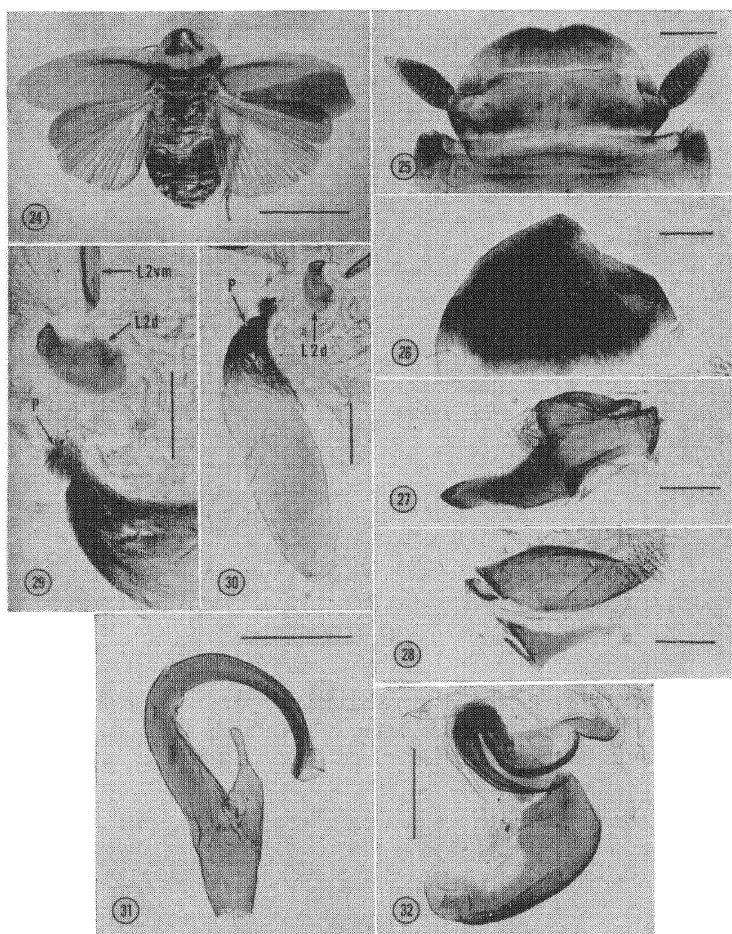
Figs. 24-32. Adult 6 of Pinaconota inaequalis (Walker) (holotype of Panchlora inaequalis Walker). 24. Adult. All structures shown in the following figs. are from this 6. 25. Supra-anal plate and eerei (dorsal). -- 26. Subgenital plate (ventral). 27. Right paraproet. 28. Left paraproet. 29- 32. Parts of the genitalia; fig. 30 shows the entire preputial modification, which is only partly shown in fig. 29. (L2vm ventromedial selerite (only apex is shown); L2d dorsal sclerite of second left phallomere; P preputial membrane). 31. R2 (second selerite of right phallomere). 32. L1 (first selerite of left phallomere). (scale" fig. 24- 10 mm; figs. 25-26 mm; figs. 27, 28, and 32 0.5 mm; fig. 29 0.4 mm; figs. 25-32 from KOH cleared, flattened preparations on 2 slides labeled 66